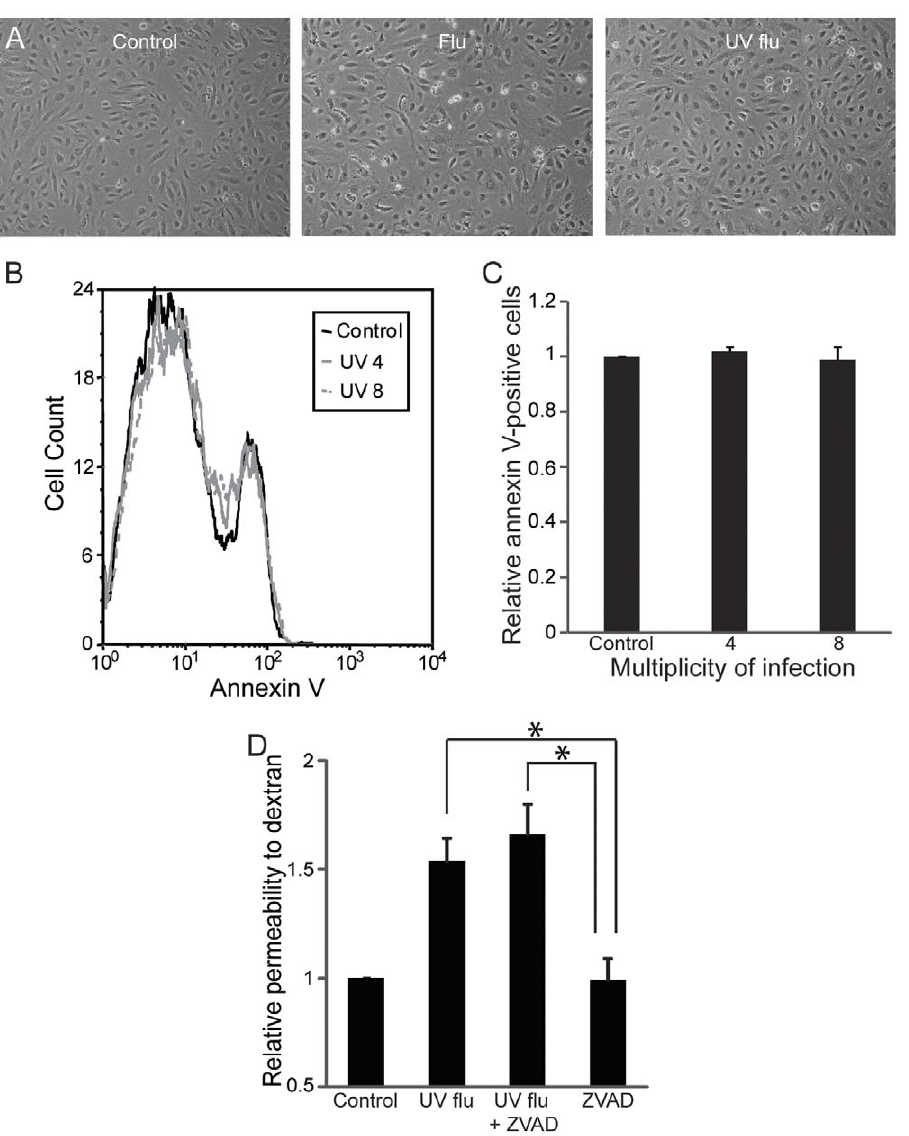
Figure 6. Replication-deficient influenza does not induce apoptosis. (A) Lung endothelium was infected with live or replication-deficient influenza (MOI 8) for 24 hours and then visualized by phase contrast microscopy. Cells exposed to replication-deficient influenza appear much healthier than cells infected with live virus and similar to infected cells. Images were captured as above and are representative of 3 experiments. (B–C) Endothelial apoptosis after exposure to replication-deficient influenza at the indicated MOI was assessed by binding of Annexin V 24 hours later. Histogram (B) is representative of 5 experiments. The percentage of Annexin V-positive cells (C) was similar in all groups. Results (mean, SE) are from 5 experiments. (D) The caspase-inhibitor ZVAD-FMK does not attenuate endothelial permeability induced by replication-deficient influenza. Cells were infected with UV flu (MOI 8) with or without 80 m M ZVAD-FMK for 24 hours. Permeability to dextran was measured. Results (mean, SD) are representative of 3 experiments, *p ,